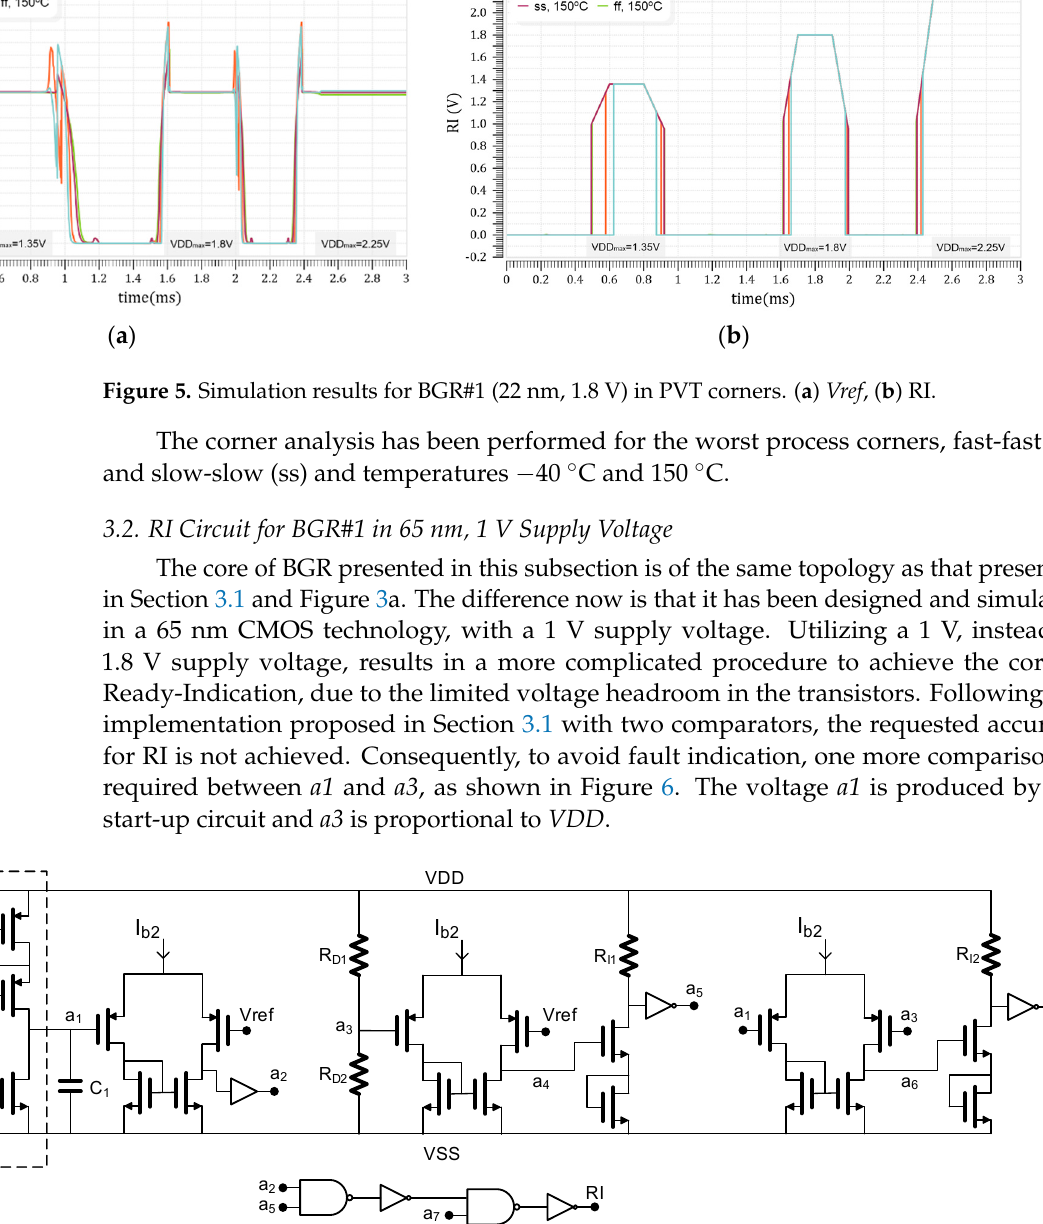
Figure 6. The RI circuit for BGR#1 in CMOS 65 nm technology and 1 V supply voltage.